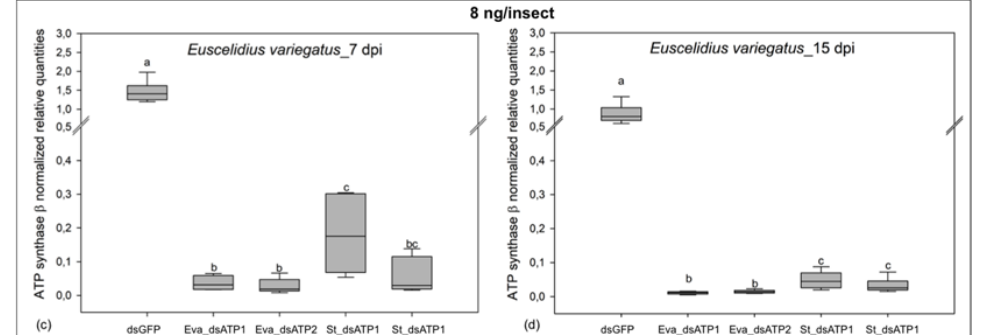
Figure 6. Transcript level of ATP synthase β in Euscelidius variegatus injected with different doses and different dsRNA constructs. Transcript level of ATP synthase β in insects injected with 80 ( a , b ) and 8 ( c , d ) ng/insect of dsRNAs targeting green fluorescent protein (dsGFP) or ATP synthase β of E. variegatus (Eva_dsATP1, Eva_dsATP2) and of Scaphoideus titanus (St_dsATP1 and St_dsATP2), collected and analyzed at seven ( a , c ) and 15 ( b , d ) days post injection (dpi). Within the same date and dose, different letters indicate significant differences in transcript levels (ANOVA, followed by Holm–Sidak method). The median of five to seven samples is shown as a line across each box, the box indicates the 25th and 75th percentiles and whiskers represent the 90th and 10th percentiles. Silencing of ATP synthase β with the newly designed dsRNAs (Eva_dsATP2, St_dsATP1 and St_dsATP2) caused the alteration of ovaries and the absence/reduction in collected offspring from injected parental E. variegatus adults (Figure 7 and Table 3).